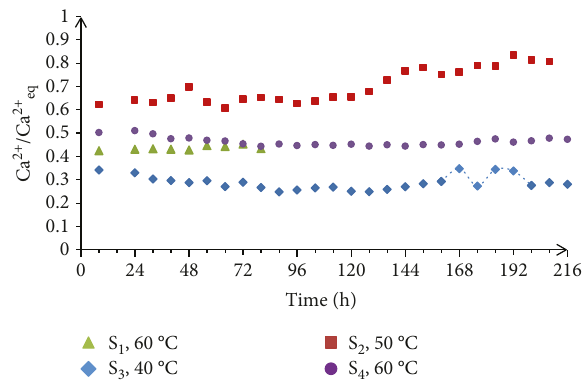
Figure 11: Variation in Ca 2+ /Ca 2+ refers to the ICP instrument being rebooted due to the replacement of the instrument operation